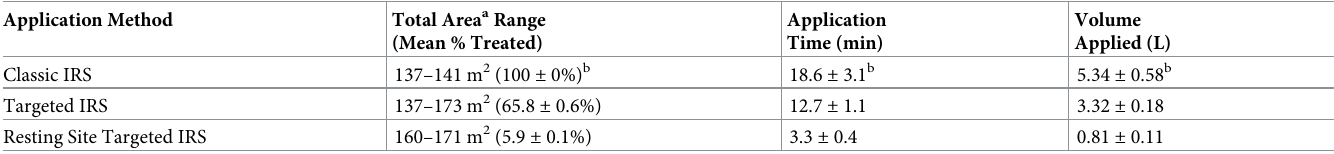
Table 1. Application time and volume of insecticide applied within experimental houses for the three IRS application